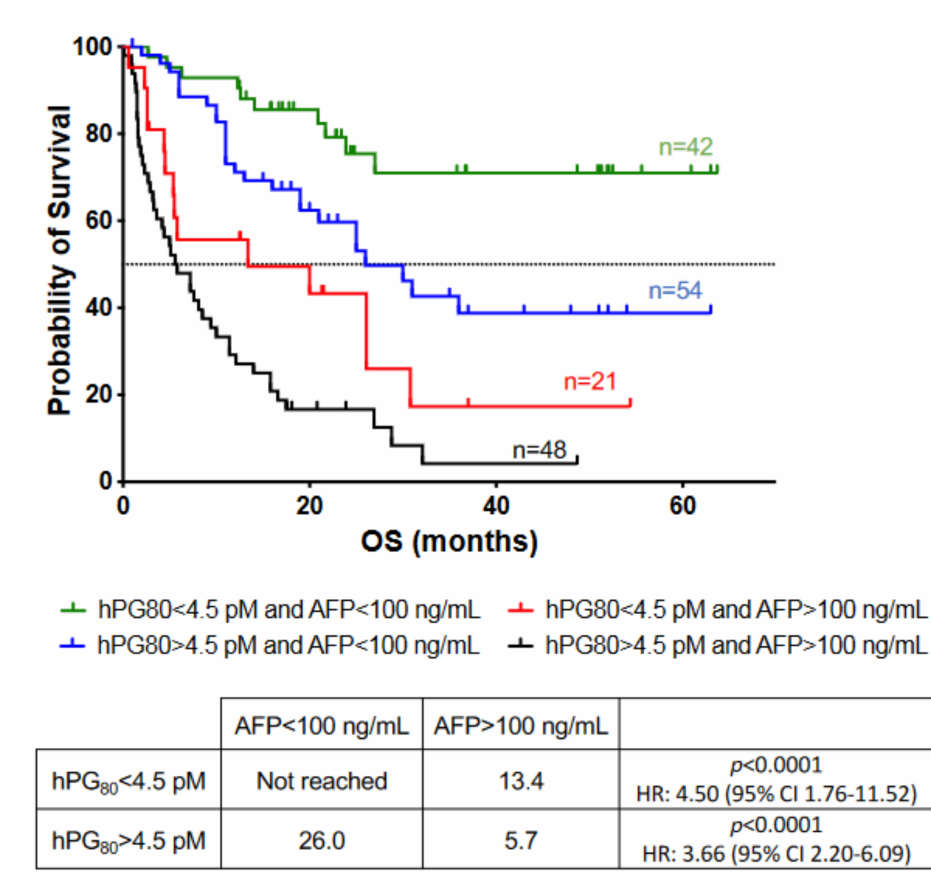
Figure 4. Overall survival of HCC patients based on combined hPG 80 and AFP levels. Kaplan- Meier analysis of OS for HCC patients according to hPG 80 and then to AFP levels (hPG 80 < 4.5 pM and AFP < 100 ng/mL: n = 42; hPG 80 < 4.5 pM and AFP > 100 ng/mL: n = 21; hPG 80 > 4.5 pM and AFP < 100 ng/mL: n = 54, hPG 80 > 4.5 pM and AFP > 100 ng/mL: n =